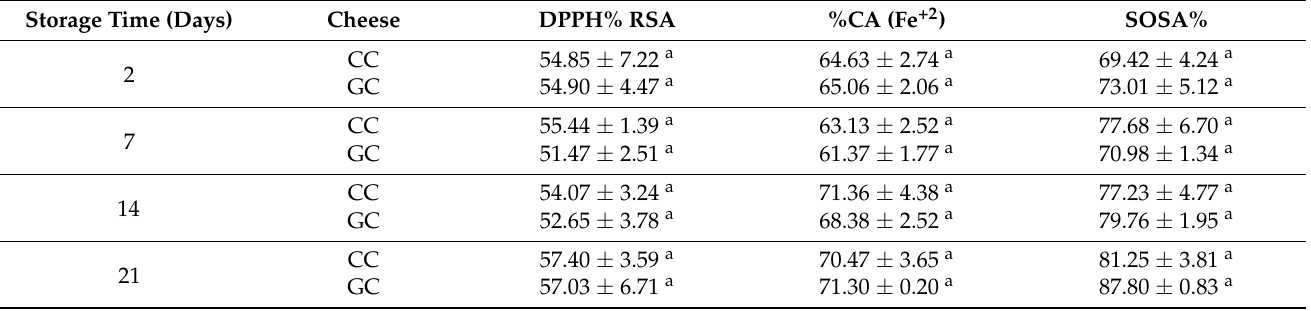
Table 6. Antioxidant capacity of GC and CC fresh spreadable cheeses made from ovine milk. Storage Time (Days) Cheese